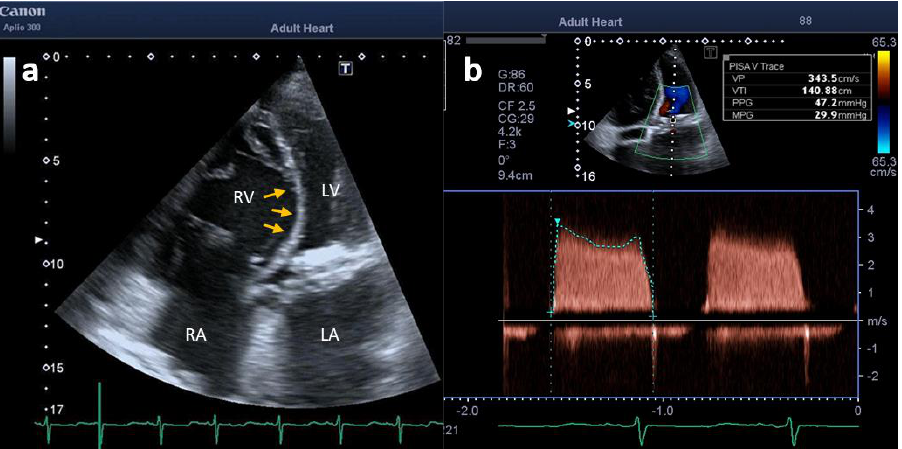
Figure 2. TTE showing ( a ) dilatation and overload of right chambers (arrows) in apical four − chamber view and ( b ) high trans—prosthetic mitral valve velocities and gradients ( b ). LA: left atrium; LV: left ventricle; RA: right atrium; RV: right